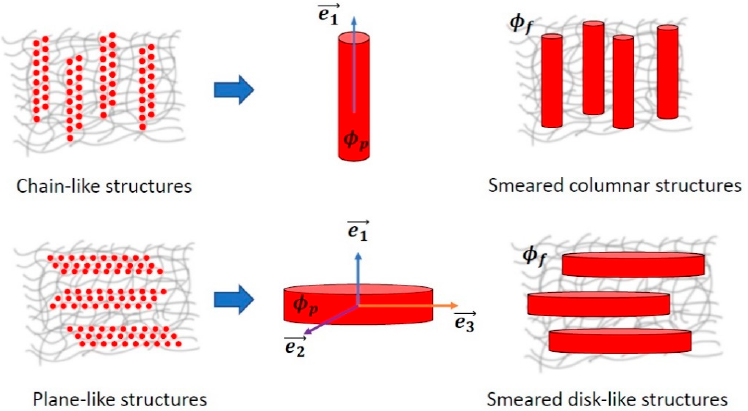
Figure 12. Smearing of magnetic particles (with total volume fraction ϕ ) into columnar and disk-like structures. ϕ p is the volume fraction of magnetizable particles inside a smeared structure, and ϕ f = ϕ / ϕ p represents the volume fraction of smeared structures inside an elastomer matrix. MAEs, in both cases, exhibit transverse isotropy along a unit vector 𝑒⃗ (cid:2869) [135].